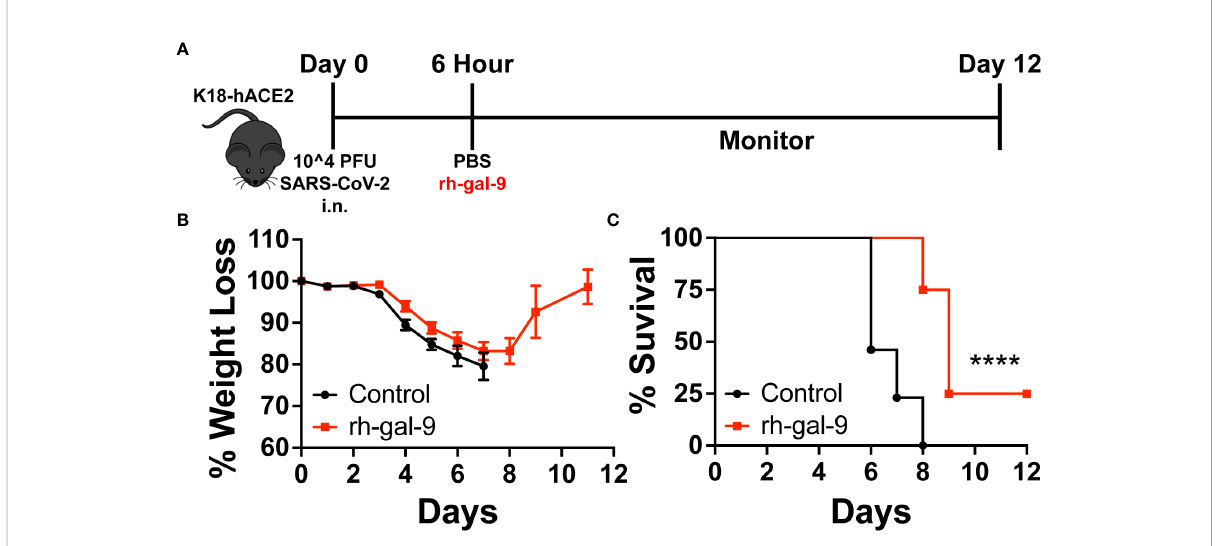
FIGURE 3 Recombinant human galectin-9 (rh-gal-9) treatment protects against SARS-CoV-2 infection in vivo. (A) Schematic for experiment plan for survival studies. (B) Weight and (C) Survival curve of 6 – 8-week-old male K18-hACE2 transgenic mice were infected intranasally with 1x10^4 PFU SARS-CoV-2 (USA/WA1/2020), 6 hpi, mice either received a bolus of 1xPBS (black) or 30 µg of rh-gal-9 (red) intraperitoneally. n = 13-23/group, ****p<0.0001. Log-rank (Mantel Cox) test. Data are represented as mean +/-